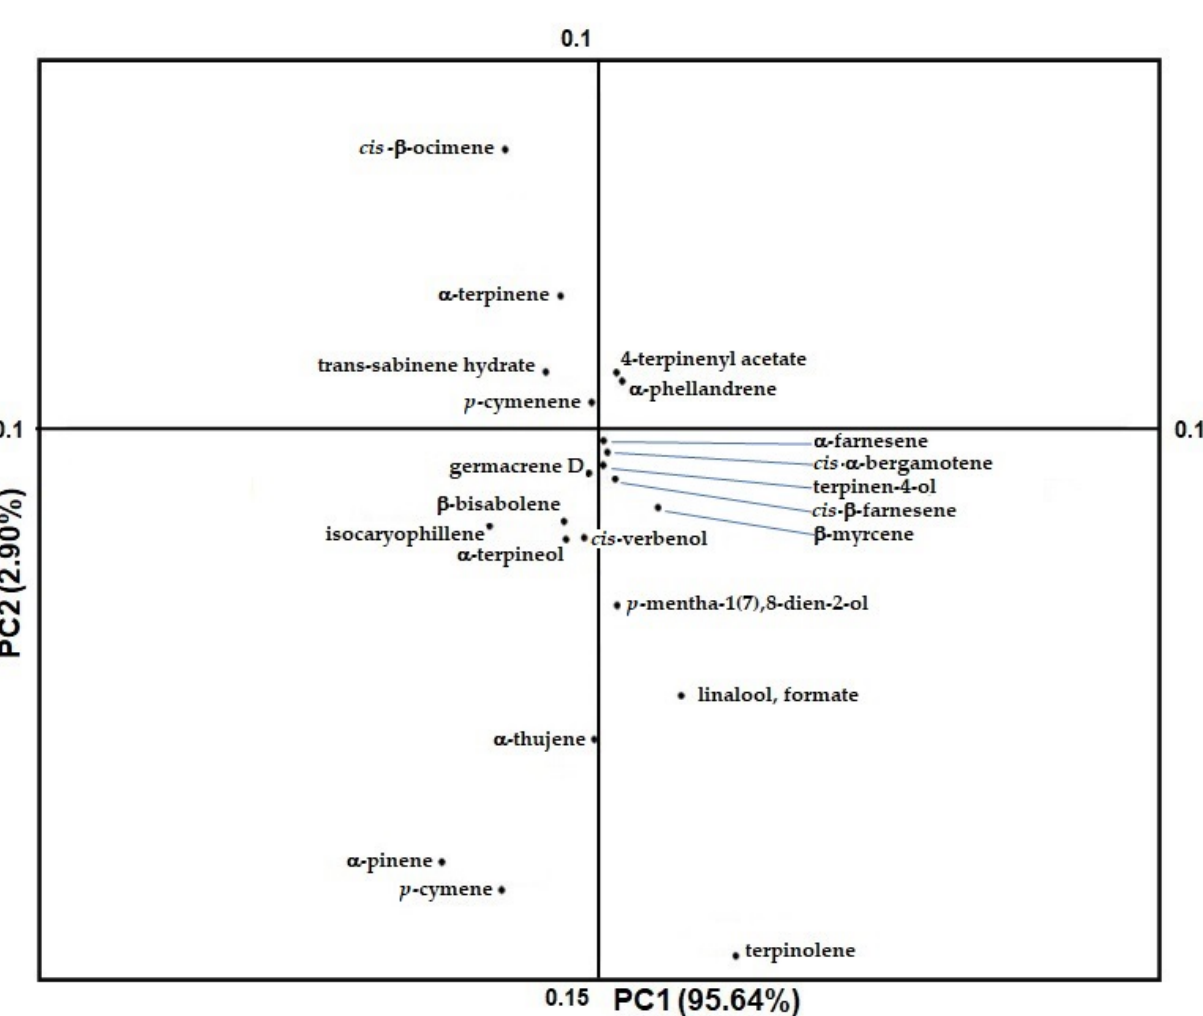
Figure 3. Detail of loading plot of volatile products extracted from citrus samples (juice and peel).